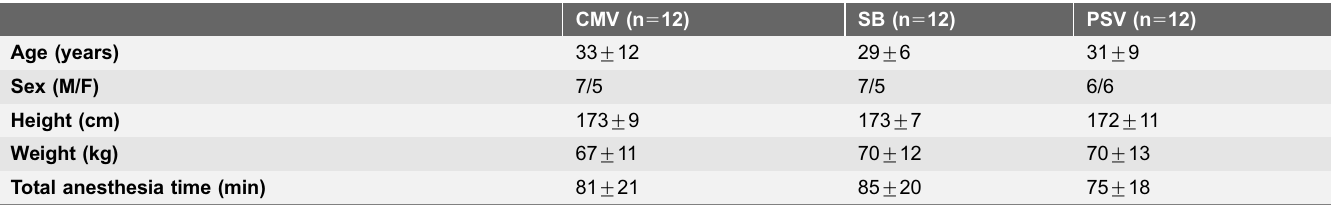
Table 1. Patient and anesthetic